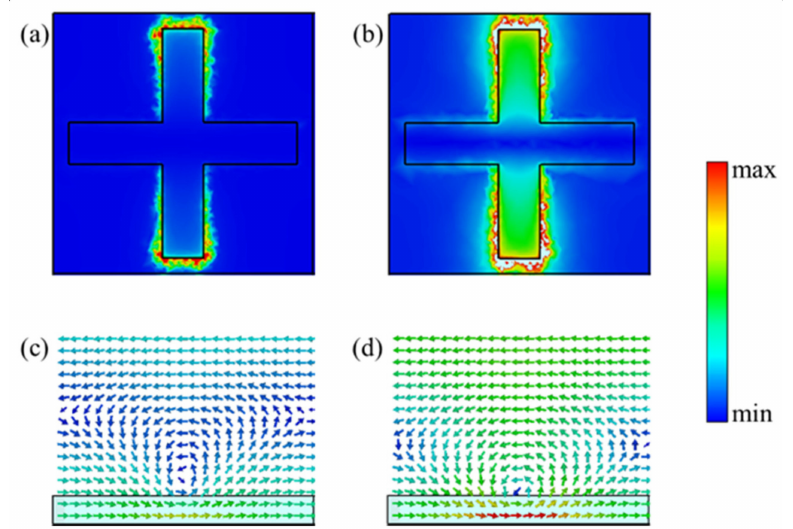
Figure 6. Simulated amplitude distribution of the electric field in reflection mode with ( a ) µ c = 0.24 eV, λ = 6.8 µ m and ( b ) µ c = 0.24 eV, λ = 6.5 µ m. Simulated cross-section magnetic field distribution in reflection mode with ( c ) µ c = 0.24 eV, λ = 6.8 µ m and ( d ) µ c = 0.24 eV, λ = 6.5 µ